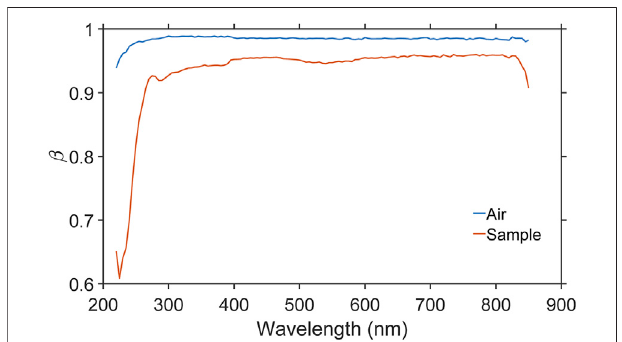
FIGURE 4 | Measured values of the depolarization β with and without a sample (Air). For wavelengths below 300 nm, we see a steep drop for the sample measurements, which is not present in the air measurement. This demonstrates sample depolarization for lower wavelengths. The depolarization measured without the sample is referred to as the instrument